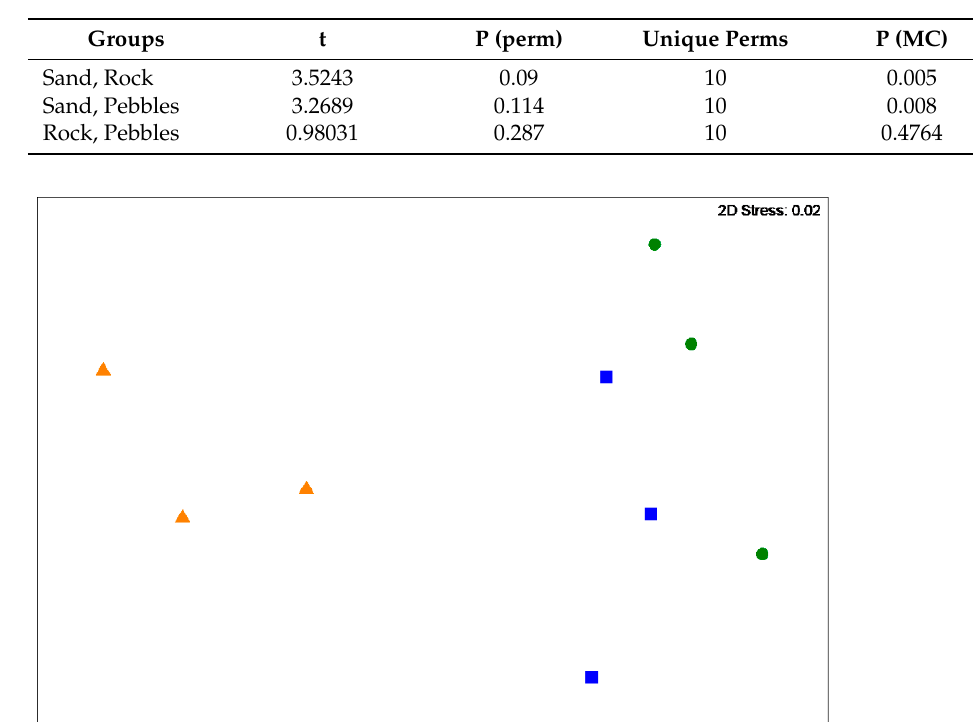
Table 3. Results of pair-wise tests for scavenging megafaunal assemblages between habitats.